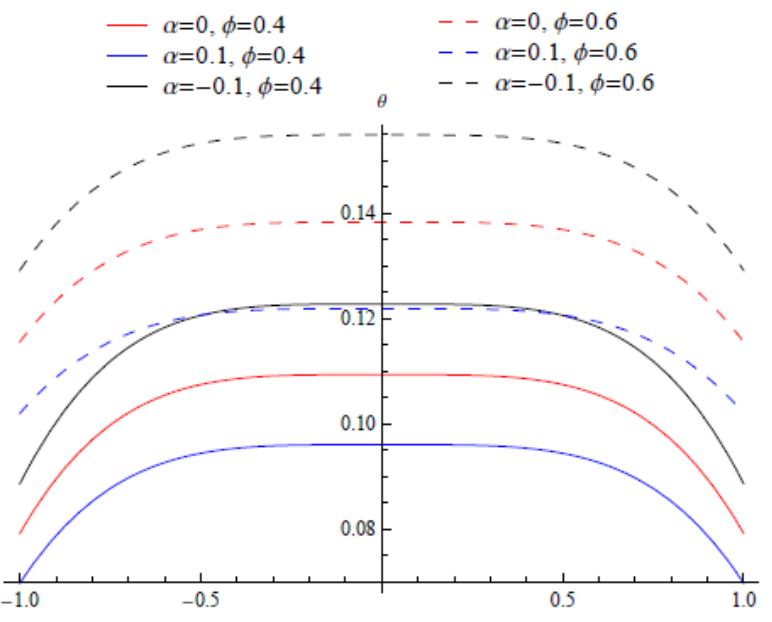
Fig. 11. Effect of ,  on temperature at 0.2, 0.3, 0.2